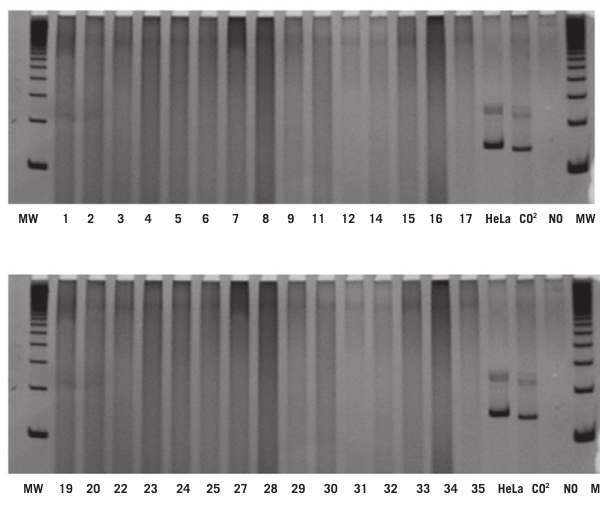
FigurE 2 − Electrophoresis in 8% polyacrylamide gel stained with silver nitrate. HPV amplification (142 bp) HPV: human papillomavirus; MW: 100 bp DNA ladder; HeLa: DNA from HPV 18-infected cervical carcinoma cell line; CO 2 : condyloma DNA; NO: no DNA control; DNA: deoxyribonucleic acid; MW: molecular